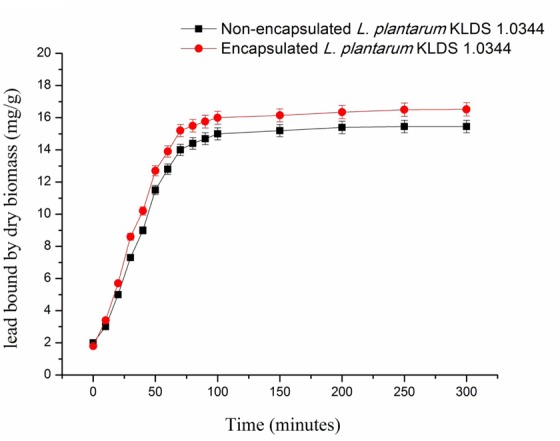
Lead of binding of Non-encapsulated and PRS-based encapsulated L. plantarum 1.0344 at different time points. Values are given as mean ± standard deviation (SD).